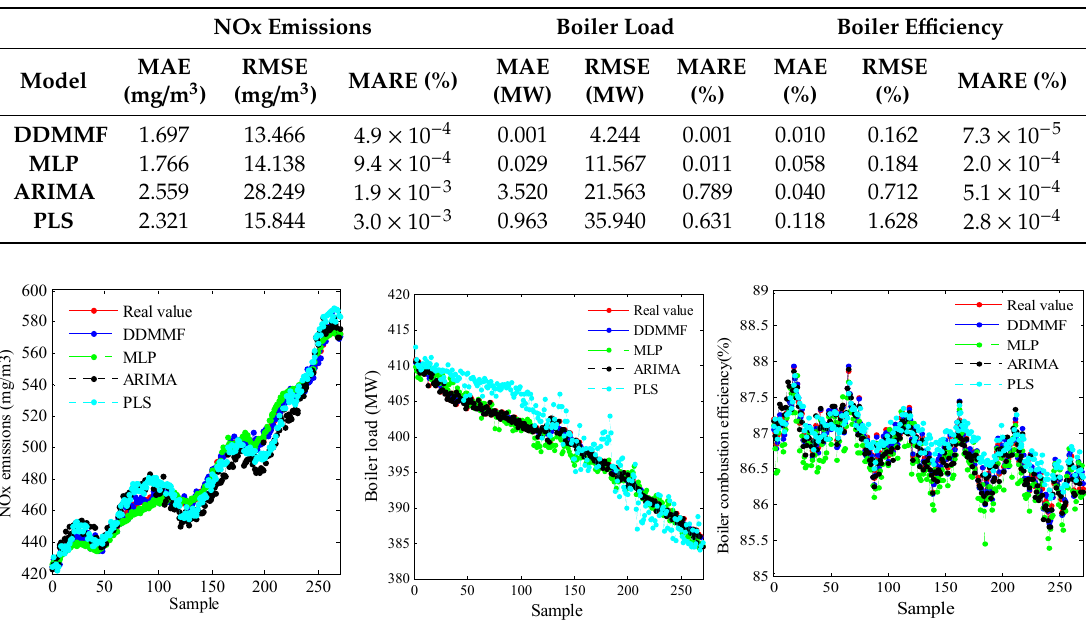
Energies 2018 , 11 , x FOR PEER REVIEW Figure 5. The predicted values obtained from di ff erent prediction models for operating condition 2. Figure5. The predicted values obtained from different prediction models for operating condition 2.